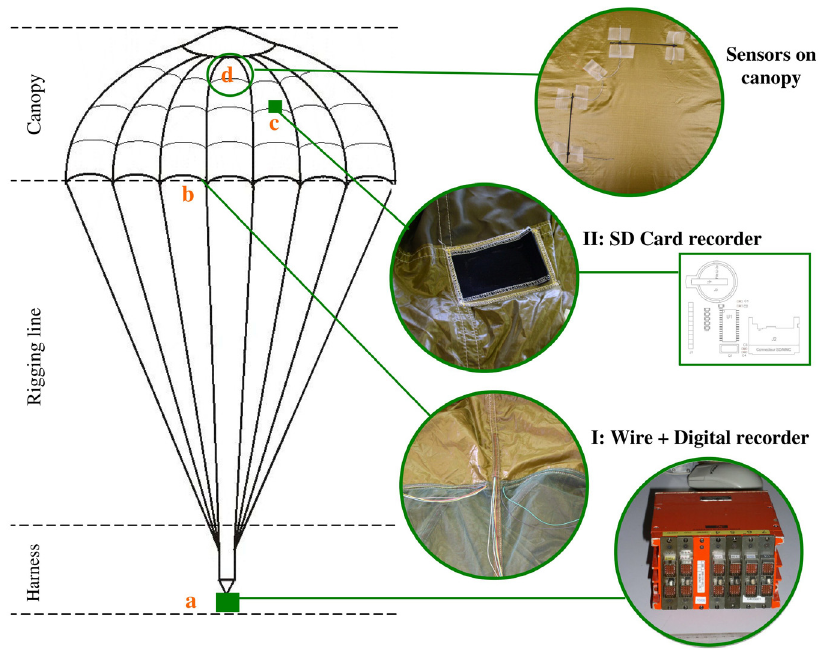
Figure 1. Location of instrumentation on a